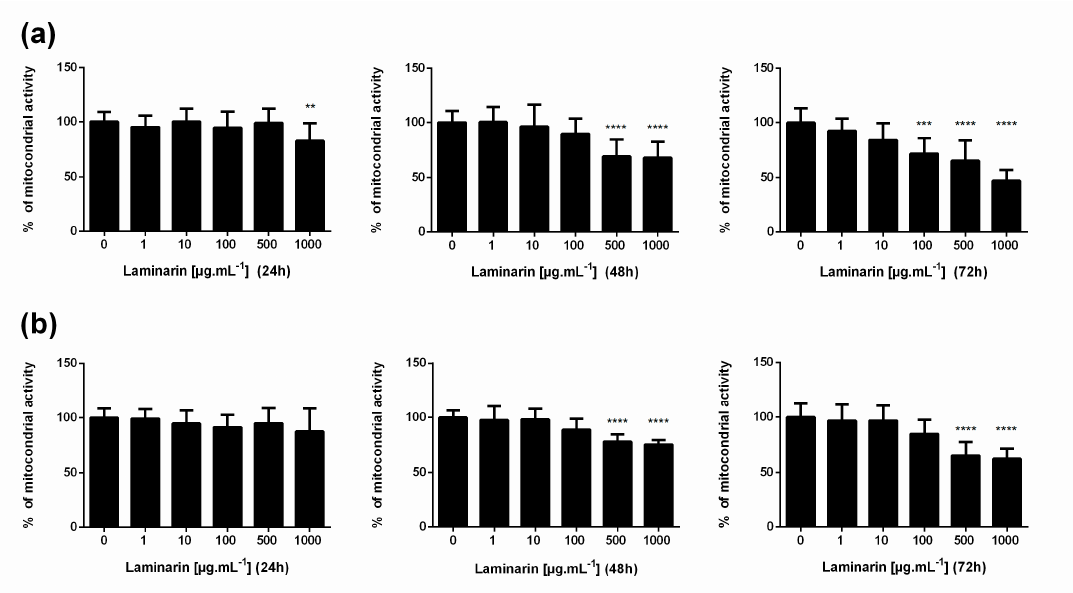
Figure 2. Evaluation of cellular metabolic activity by the MTT assay. HDFa ( a ) and NHEK cells ( b ) were stimulated with 1, 10, 100, 500 and 1000 µg.mL − 1 laminarin for 24 h (left), 48 h (middle) and 72 h (right) and cellular metabolic activity was performed using a tetrasodium salt (MTT). Data are expressed as mean ± SD of three independent experiments. ** p ≤ 0.01, *** p ≤ 0.001, **** p ≤ 0.0001 compared with 0 µg.mL − 1 (control group).